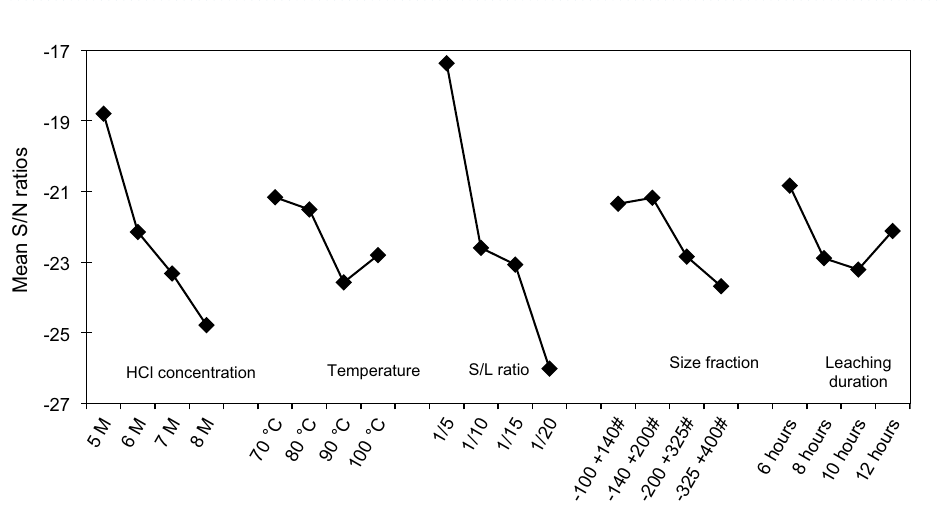
Figure 5. Profile of S/N ratio at various levels of the experimental variables which respect iron extraction percentage.